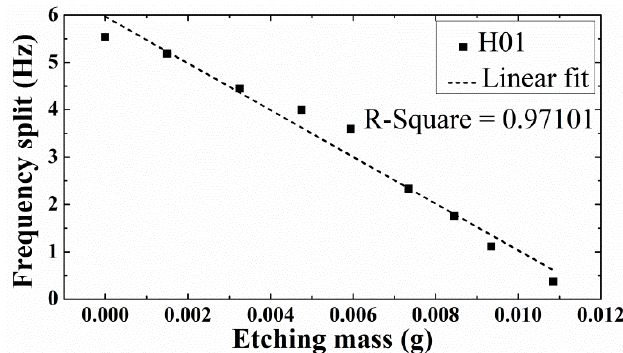
Figure 8. The frequency split change of H01 with its etching mass.